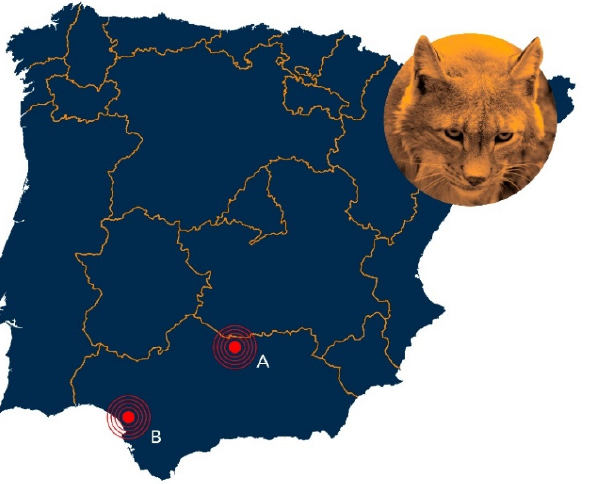
Figure 1. Map of Iberian Peninsula (Portugal and Spain). Andalusia, Southern Spain, shows Sierra Morena ( A ) and Doñana ( B ) study areas.